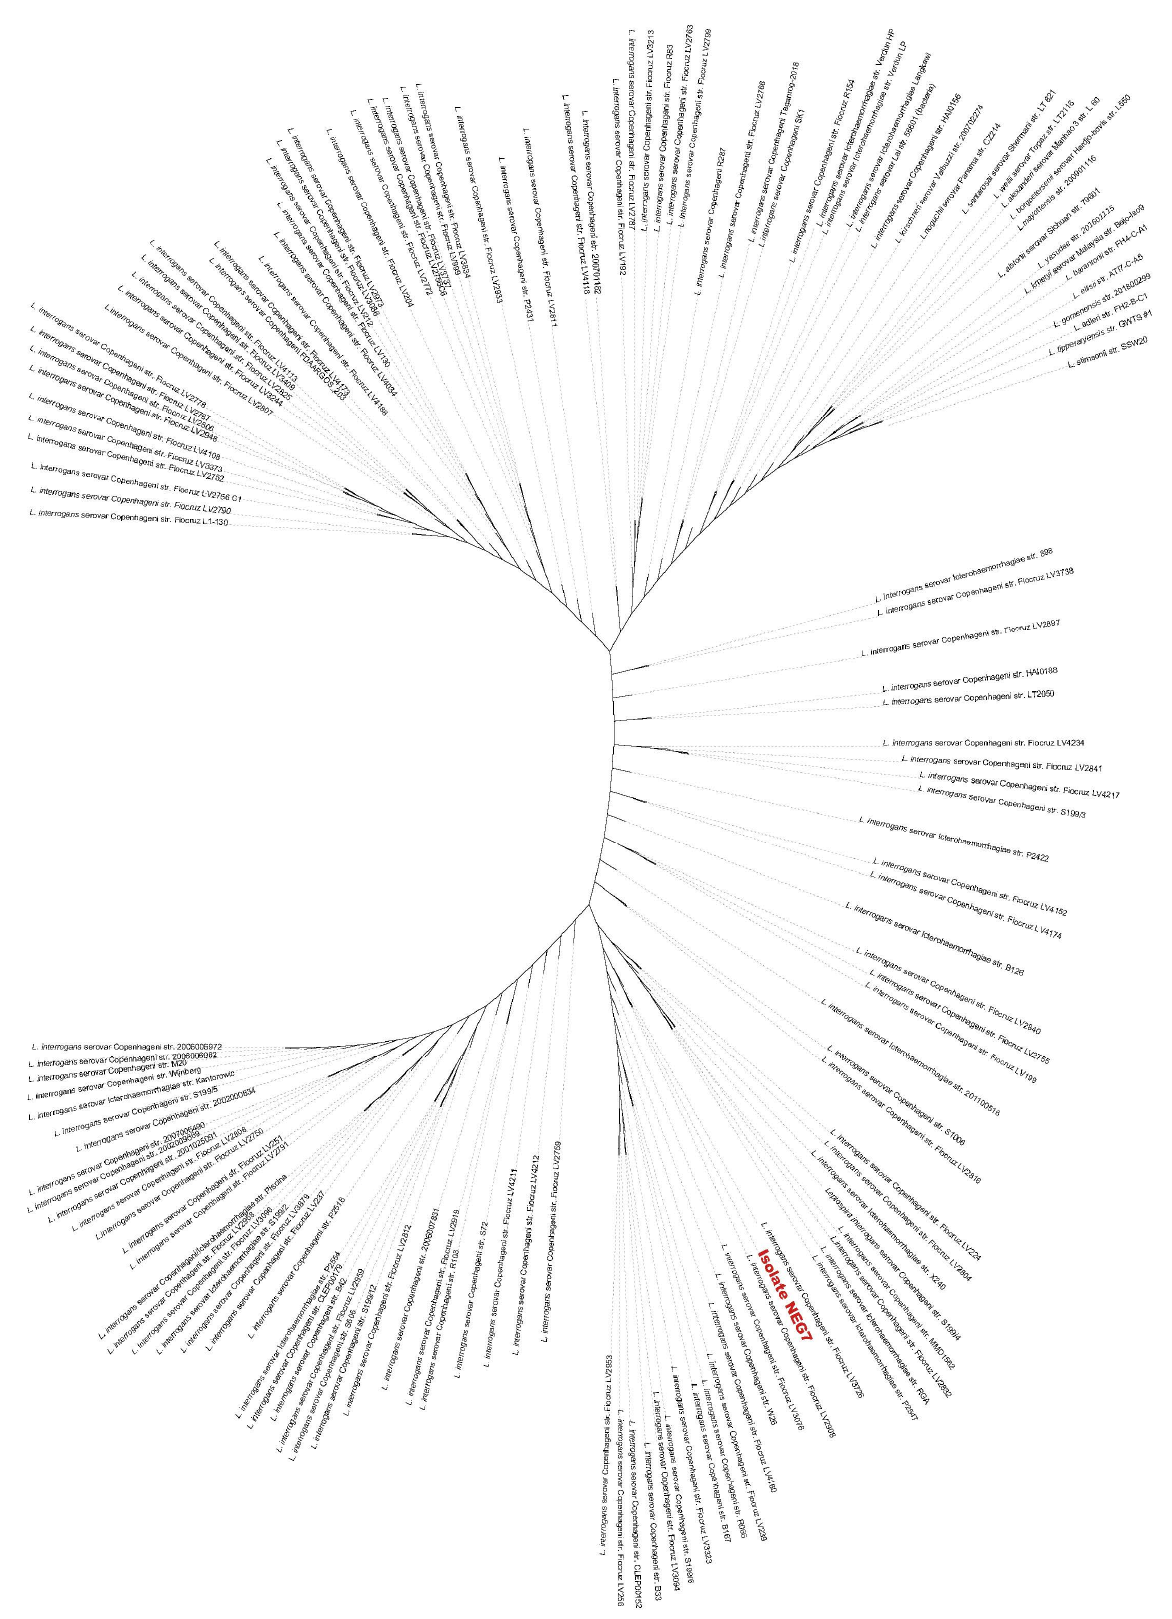
Figure 3. Maximum likelihood tree constructed based on the alignment of the syntenic regions identified as shared by different genomes of L. interrogans serovar Copenhageni and Icterohaemorrhagiae